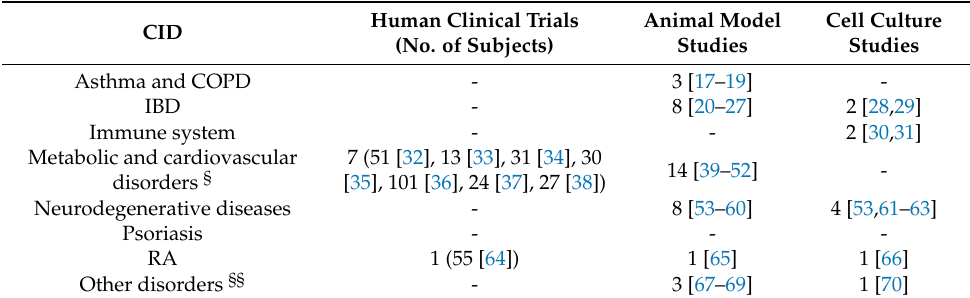
Table 1. Published research studies on the potential beneficial effects on Chronic Inflammatory Disease (CID) of pomegranate products.